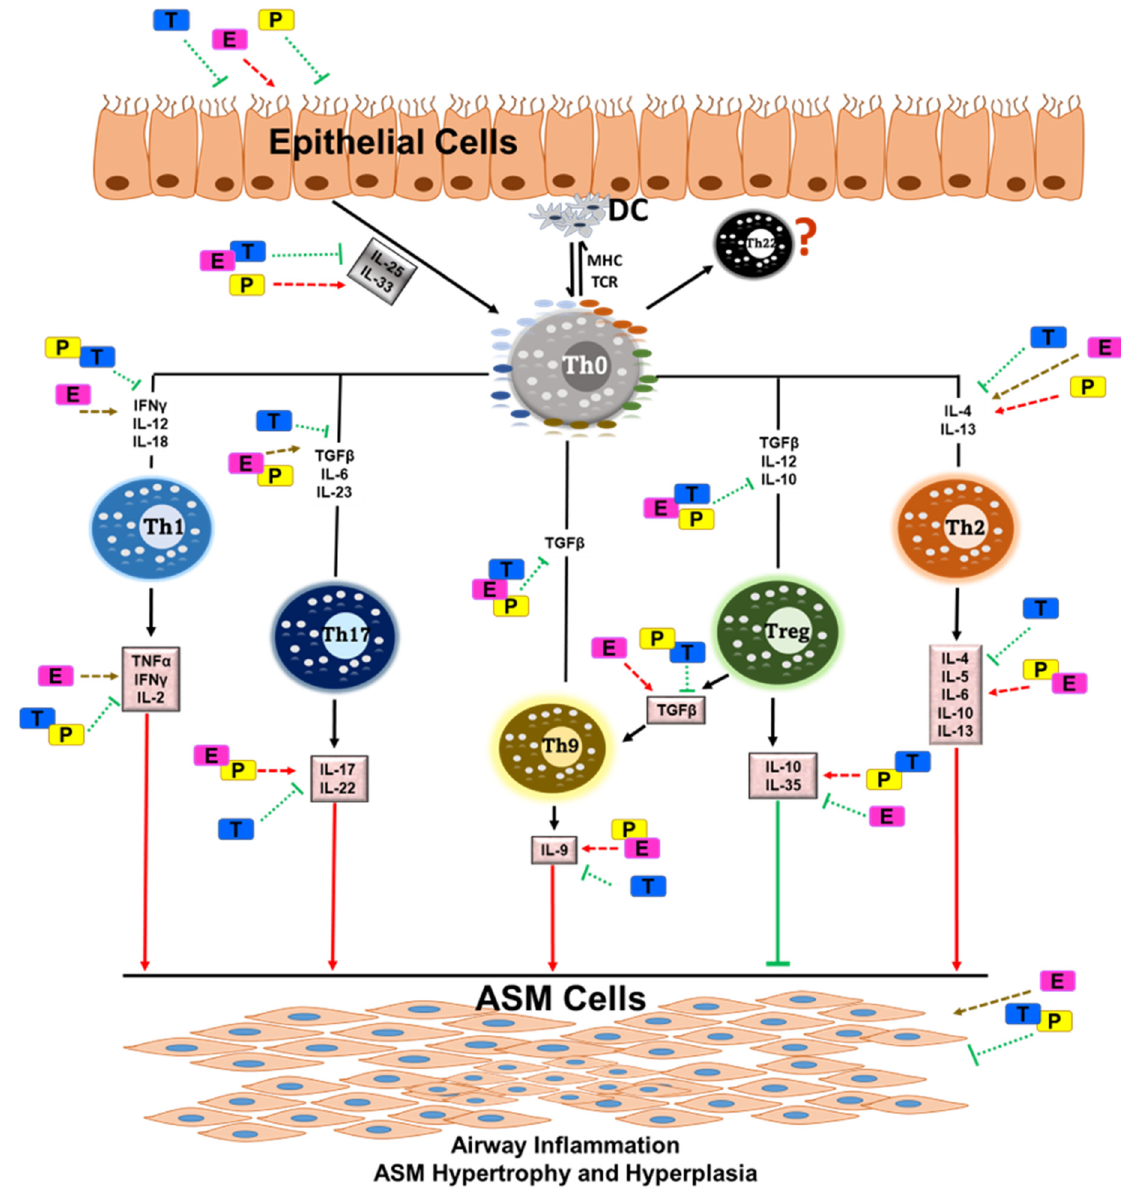
Figure 3. It is well known that asthma is a multifaceted respiratory disorder consisting of allergic triggers on the immune system and alterations in the structural cells of the airway. Overall, airway inflammation is mainly orchestrated by the T cell subsets, and the regulation of T cell subsets from naïve (Th0) cells may regulate cytokine release towards specific T-cell types. These T cells and their cytokine release are influenced by sex steroids such as estrogen, testosterone and progesterone. All these T cell subsets play key roles in recruiting, activating, and promoting the survival of multiple cell types along with altered pro- and anti-inflammatory cytokines in the airways, subsequently leading to airway smooth muscle cell (ASM) inflammation and remodeling. This is greatly influenced by circulating sex steroids, as discussed in this review. Pathways/cytokines aggravated in asthma are marked with red arrows (single and dotted), whereas pathways inhibiting airway inflammation in asthma are marked with green arrows (single and dotted). Yellow arrows denote unknown